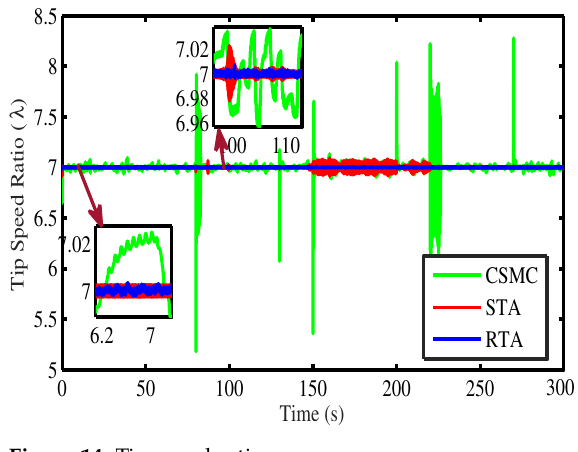
Figure 14. Tip speed ratio.